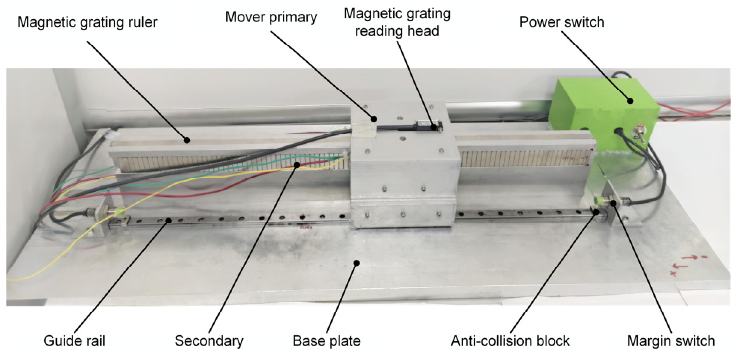
Figure 14. Electromagnetic actuator prototype. Table 5. The parameters of the electromagnetic actuator prototype.